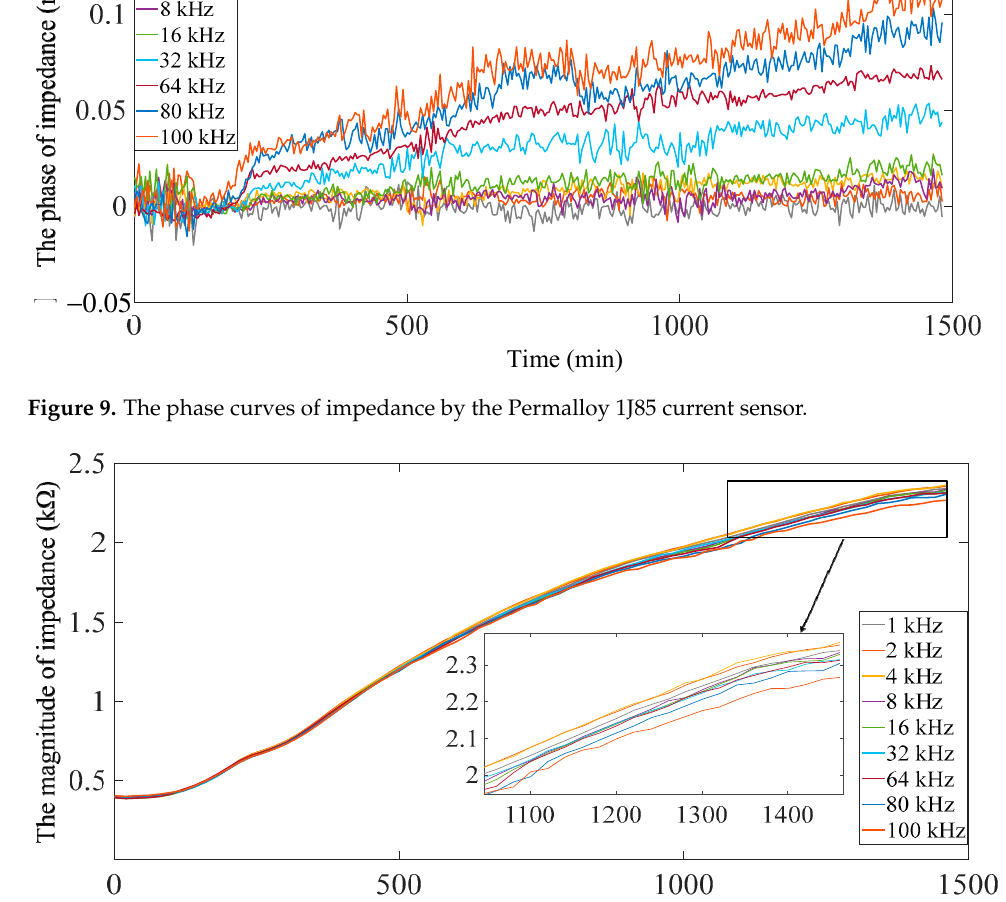
Figure 10. The magnitude curves of impedance by the nanocrystalline T37 current sensor.